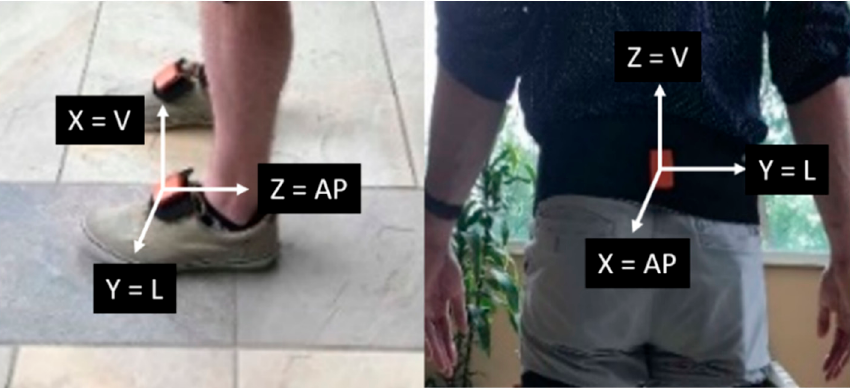
Figure 2. Sensor orientation on both the feet and pelvis. The sensor’s cartesian frame matches the walking direction (L = Lateral, V = Vertical, AP = Anterior-posterior).